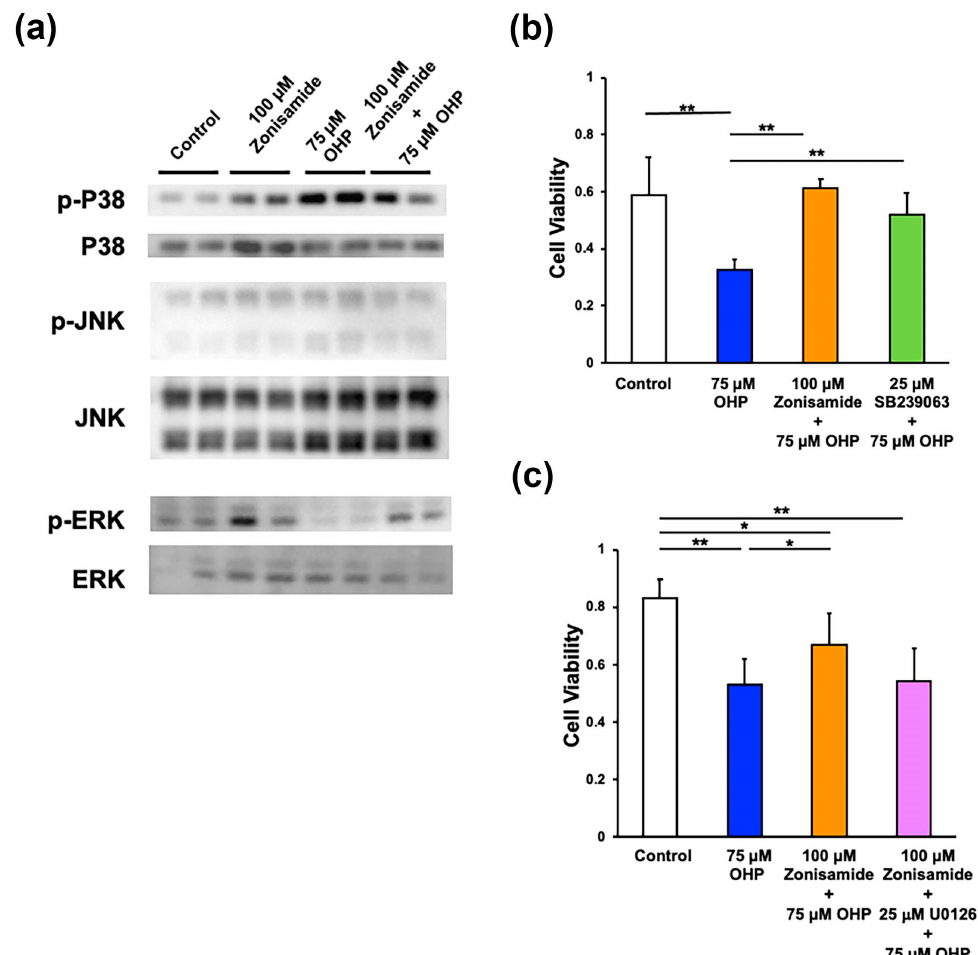
Figure 3. Involvement of MAPK signaling pathways in the protective activity of zonisamide against OHP-induced neurotoxicity: ( a ) Preincubation with 100 µ M of zonisamide for 1 h attenuates the upregulated expression of the phosphorylated p38 MAPK (p-P38) as well as the downregulated expression of the phosphorylated ERK (p-ERK) in ND7/23 cells exposed to OHP (75 μ M) for 1 h; results referring to Western blotting. The signals for p-P38/P38 and p-JNK/JNK were detected by using the same membrane. ( b ) Preincubation with 100 μ M of zonisamide or with 25 μ M of SB239063 (a p38 MAPK inhibitor) for 24 h diminishes the cell death as a result of exposure to 75 μ M of OHP for 24 h. ( c ) Co-incubation with 25 μ M of U0126 (a MEK inhibitor) weakens the alleviating effects of zonisamide (100 μ M) against the OHP-induced (75 μ M) cell death. Data are presented as the mean ± SD of ( b ) 6 and ( c ) 8 experiments, respectively; **: p < 0.01; *: p < 0.05 (as defined by Tukey–Kramer).